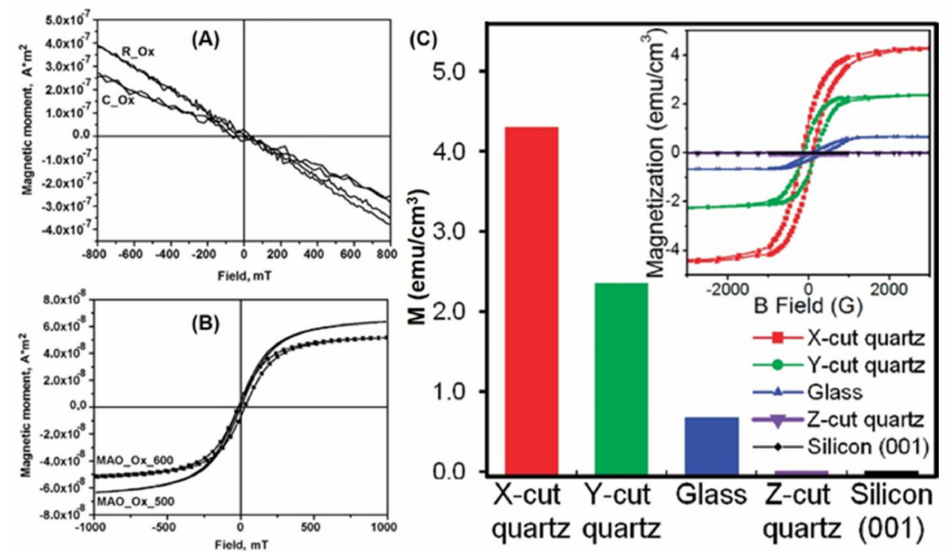
Figure 12. Substrate effects on RTFM. ( A ) M-H loops of ZnO TFs prepared by CVD on sapphire substrates (Reproduced with permission from [93]. Copyright 2019, Elsevier). ( B ) M-H loops of ZnO TFs deposited by CVD on (111) MgAl 2 O 4 substrates (Reproduced with permission from [93]. Copyright 2019, Elsevier). ( C ) M s of ZnO TFs deposited on different substrates (Reproduced with permission from [106]. Copyright 2009, American Chemical